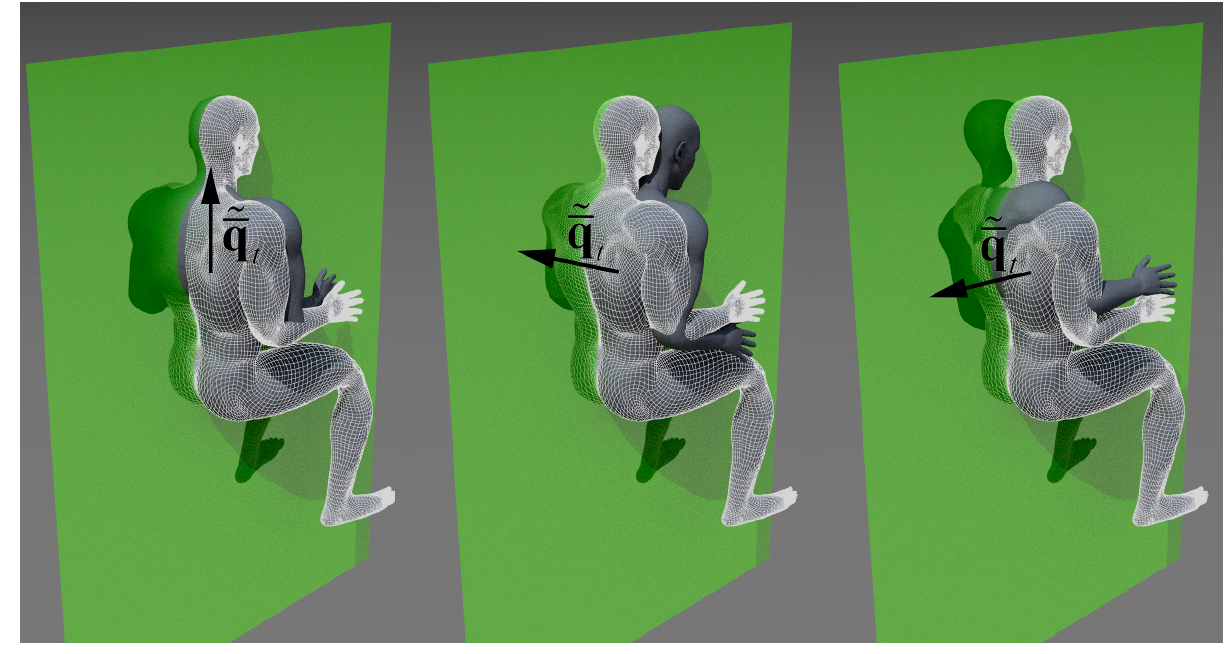
Figure 8. Average relative quaternion q t for three different rotations. The green plane is the sagittal plane and the quaternions are represented just for their vector part. Rotations are relative to the reference posture represented with the checkered mesh: ( left ) yaw; ( center ) pitch, the quaternion is orthogonal to the sagittal plane; ( right ) roll, the quaternion is horizontal in the sagittal plane.